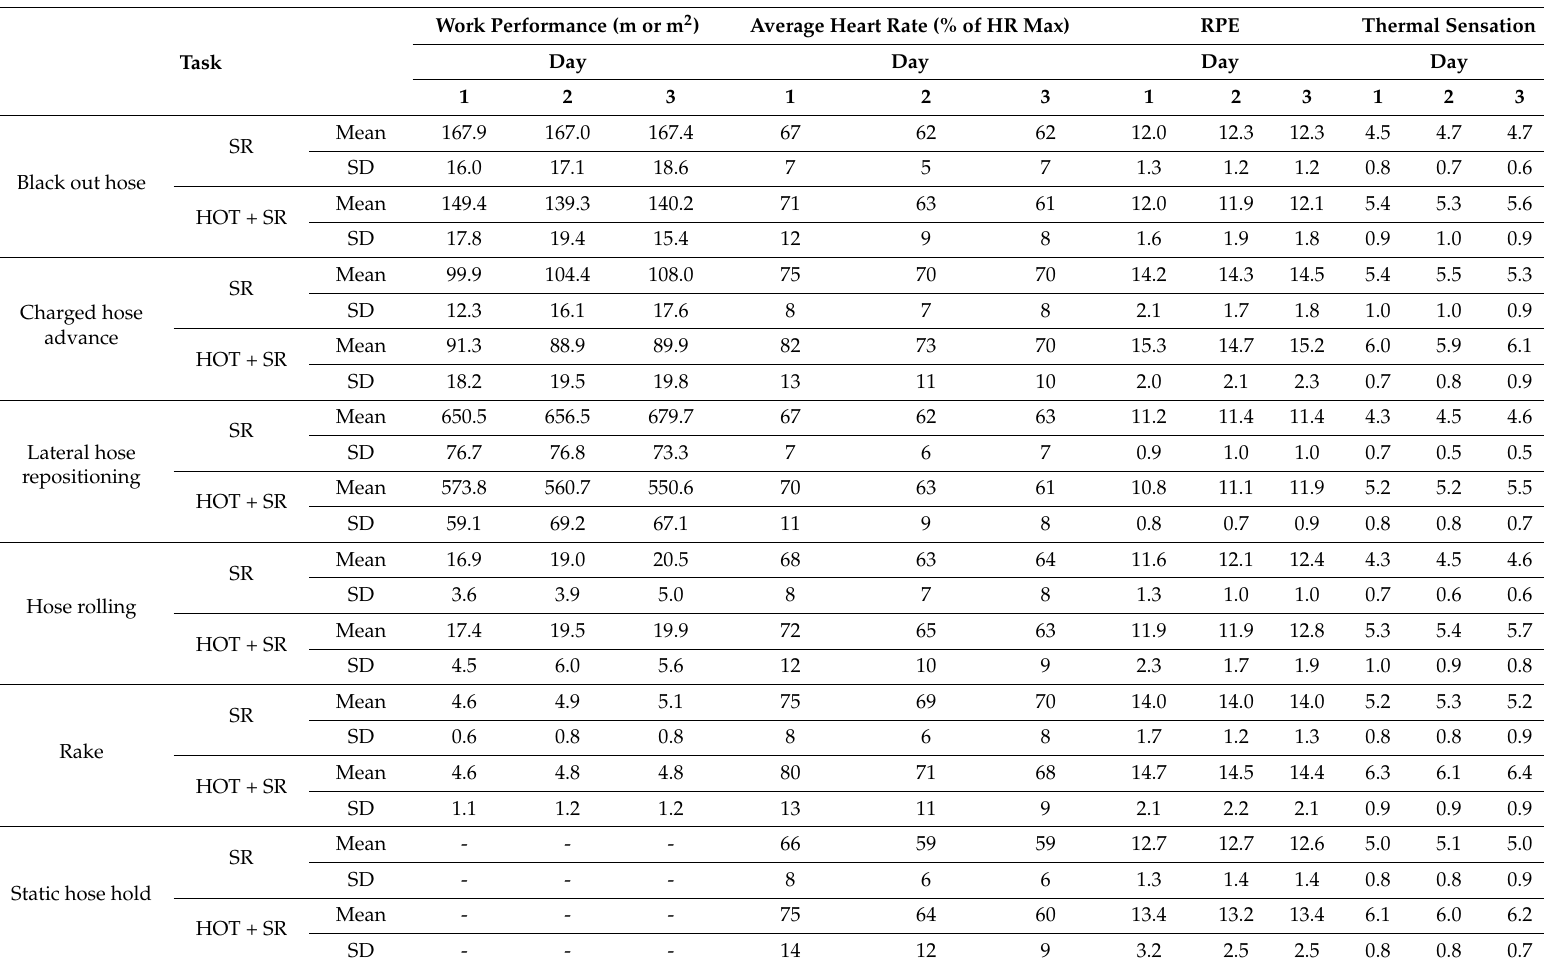
Table 3. Daily mean work performance, heart rate, RPE, and thermal sensation for the sleep restriction (SR) and hot and sleep restriction (HOT + SR) conditions. Work Performance (m or m 2 ) Average Heart Rate (% of HR Max) RPE Thermal Sensation Day Day Day Day Task 1 2 Mean SR Black out hose